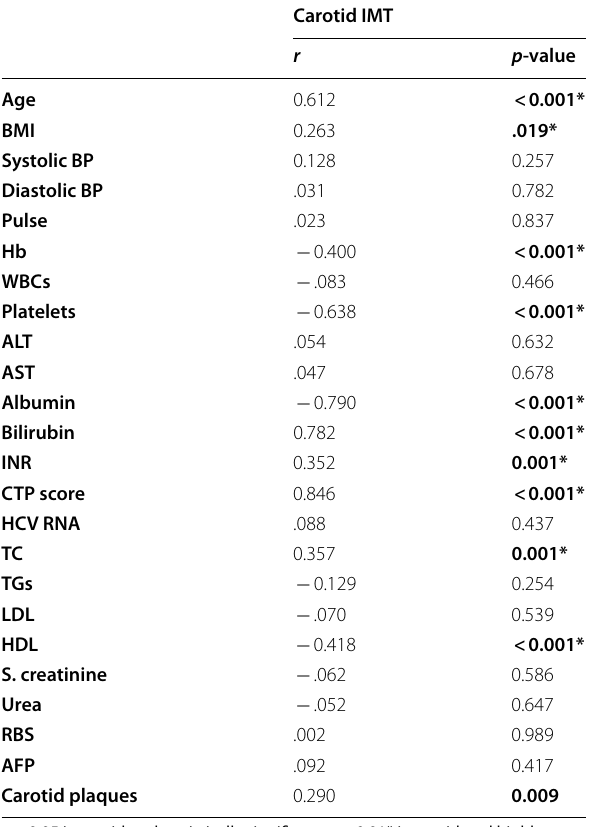
Table 8 Correlation between and baseline carotid IMT and other risk